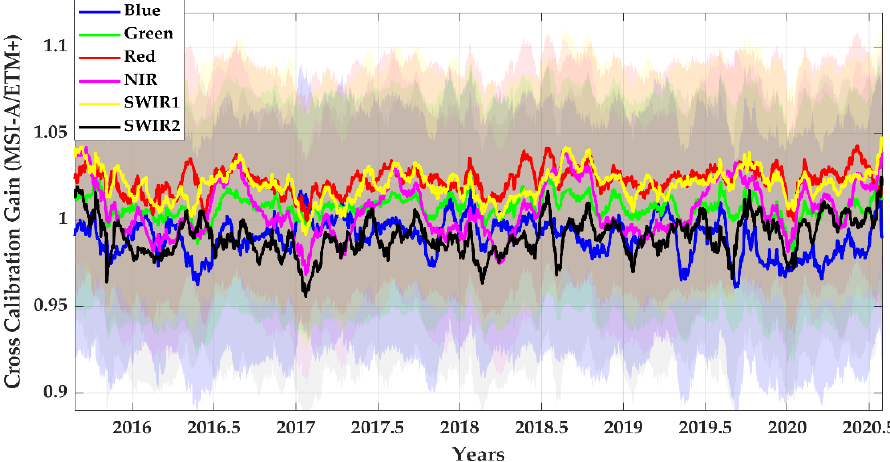
Figure 15. The trend-to-trend cross-calibration gain of Sentinel 2A MSI and Landsat 7 ETM+. The shaded region is the uncertainty for individual bands.